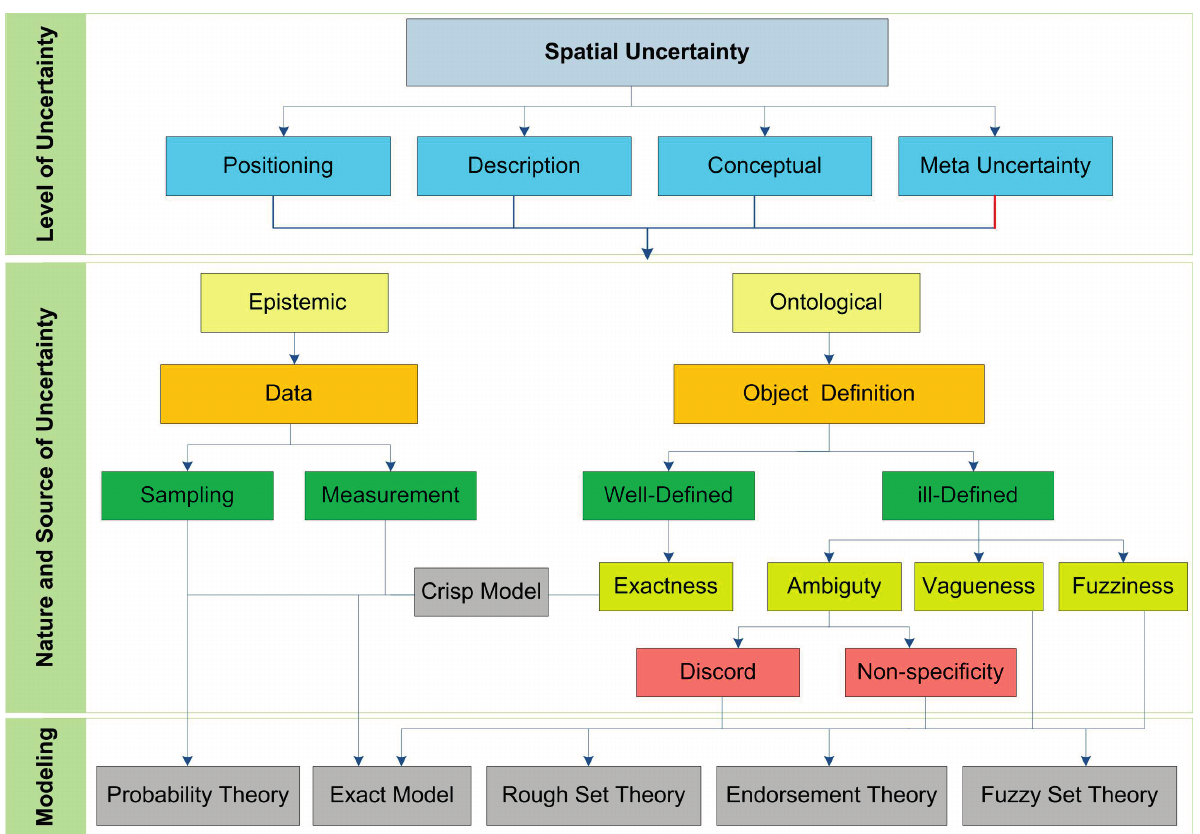
Figure 2. A comprehensive UML class diagram of spatial uncertainty in spatial data modeling and the methods to handle